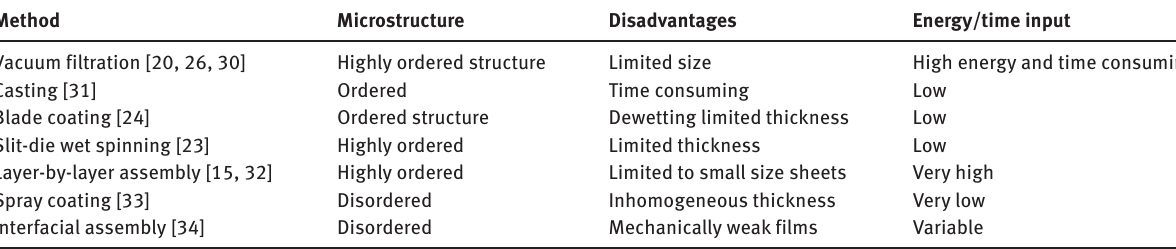
Table 1: Methods of preparation of graphene oxide films. Method